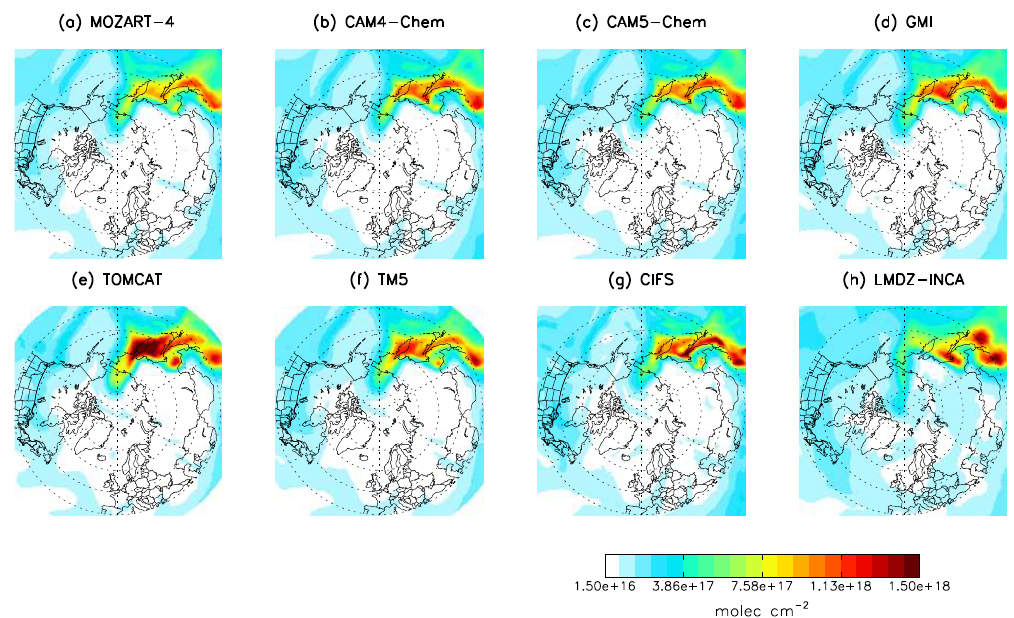
Figure 10. Total column concentrations of the 25 day fixed-lifetime Asian anthropogenic tracer from the POLMIP model simulations at 06:00UT on 7 July